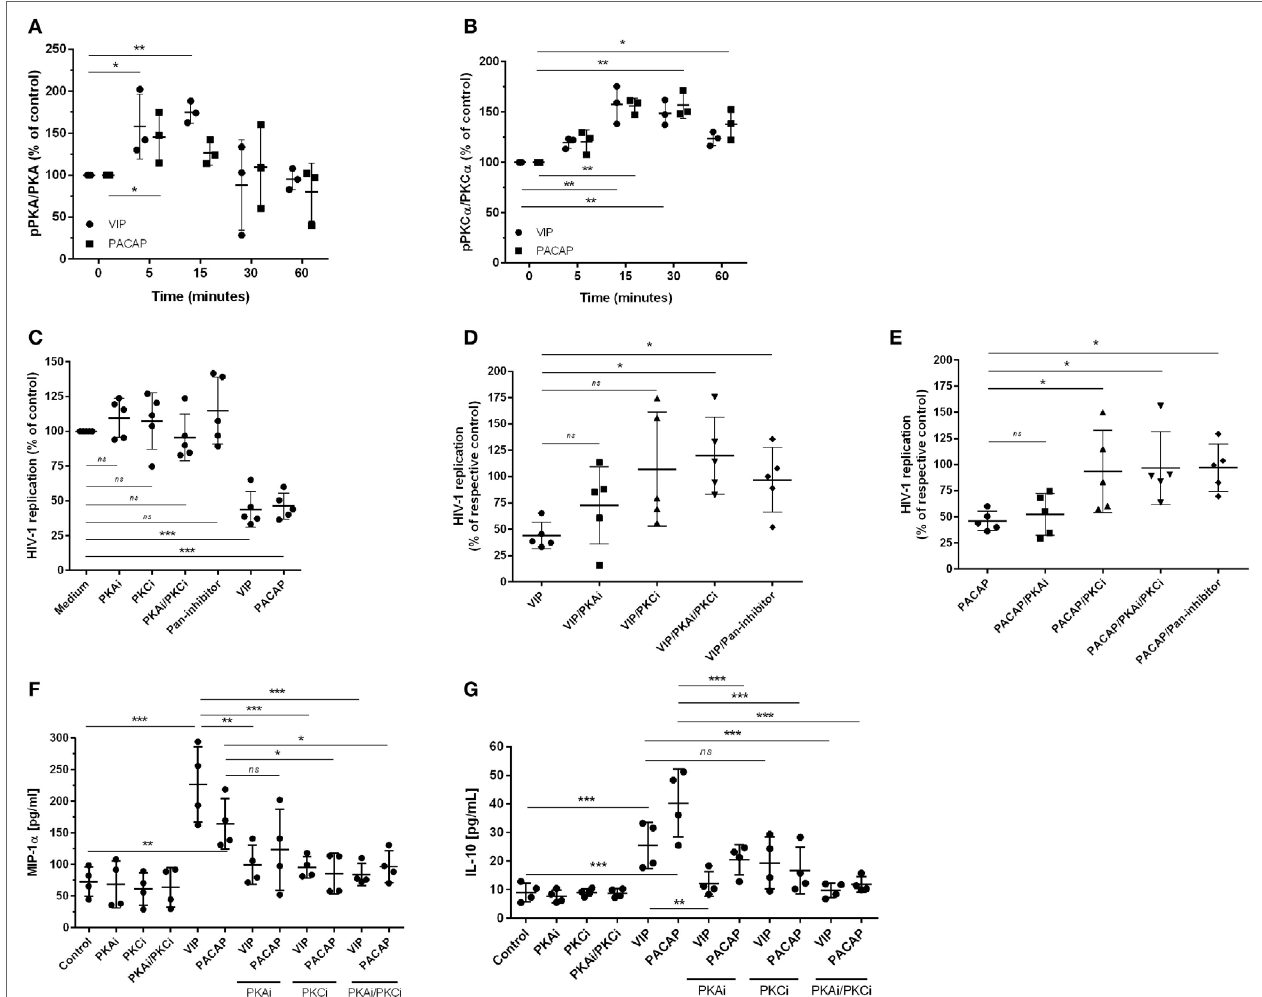
FigUre 3 | The effect of vasoactive intestinal peptide (VIP) and pituitary adenylate cyclase-activating polypeptide (PACAP) on HIV-1 replication is dependent on protein kinases A (PKA) and C (PKC). (a,B) Uninfected macrophages were treated with VIP or PACAP (10 nM) and levels of PKA and pPKA (a) , PKC α and pPKC α (B) were analyzed by western blot at different time-points; figures show the ratios between band densitometry normalized based on β -actin intensity ( n = 3). (c–e) Infected macrophages were treated with VIP or PACAP (10 nM) in the presence or not of signaling inhibitors (PKAi, H89; PKCi, Gö 6983; Pan-protein kinase inhibitor, H7, 50 nM each one) for 30 min; cells were washed before neuropeptide addition [in (c) , results are shown normalized to medium to rule out any possible inhibitor interference on HIV-1 replication]. (D,e) Treatment with VIP (D) or PACAP (e) plus inhibitors; results are shown normalized to respective controls [shown in (c) ], to compare the individual inhibitory effects. Supernatants were collected after 12 days and viral replication was measured ( n = 5). (F,g) Infected macrophages were treated with VIP or PACAP (10 nM) in the presence or not of signaling inhibitors as above, for 30 min; cells were washed before neuropeptide addition. After 48 h, supernatants were collected and production of MIP-1 α (F) and IL-10 (g) were analyzed by ELISA ( n = 4). * p < 0.05; ** p < 0.01; *** p < 0.001; one-way ANOVA, with Dunnett